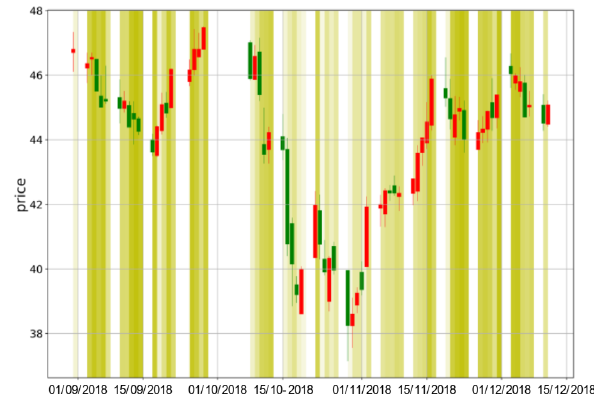
Figure 11. Spatial attention weight of a